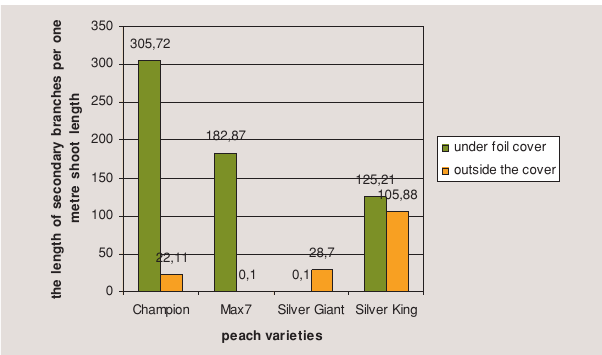
Figure 7. Specific length of secondary shoots (per one metre) developed on8 year old peach trees grown under plastic foil and outside the